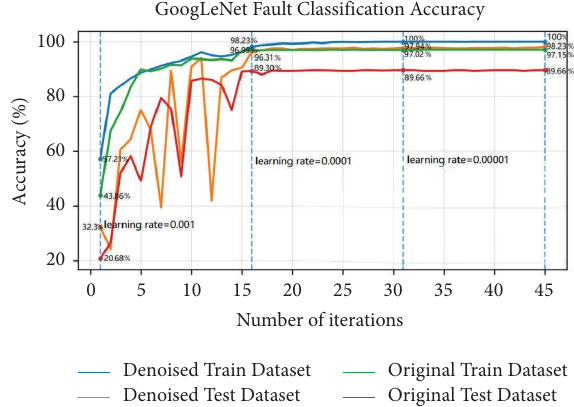
Figure 17: Faults classifcation